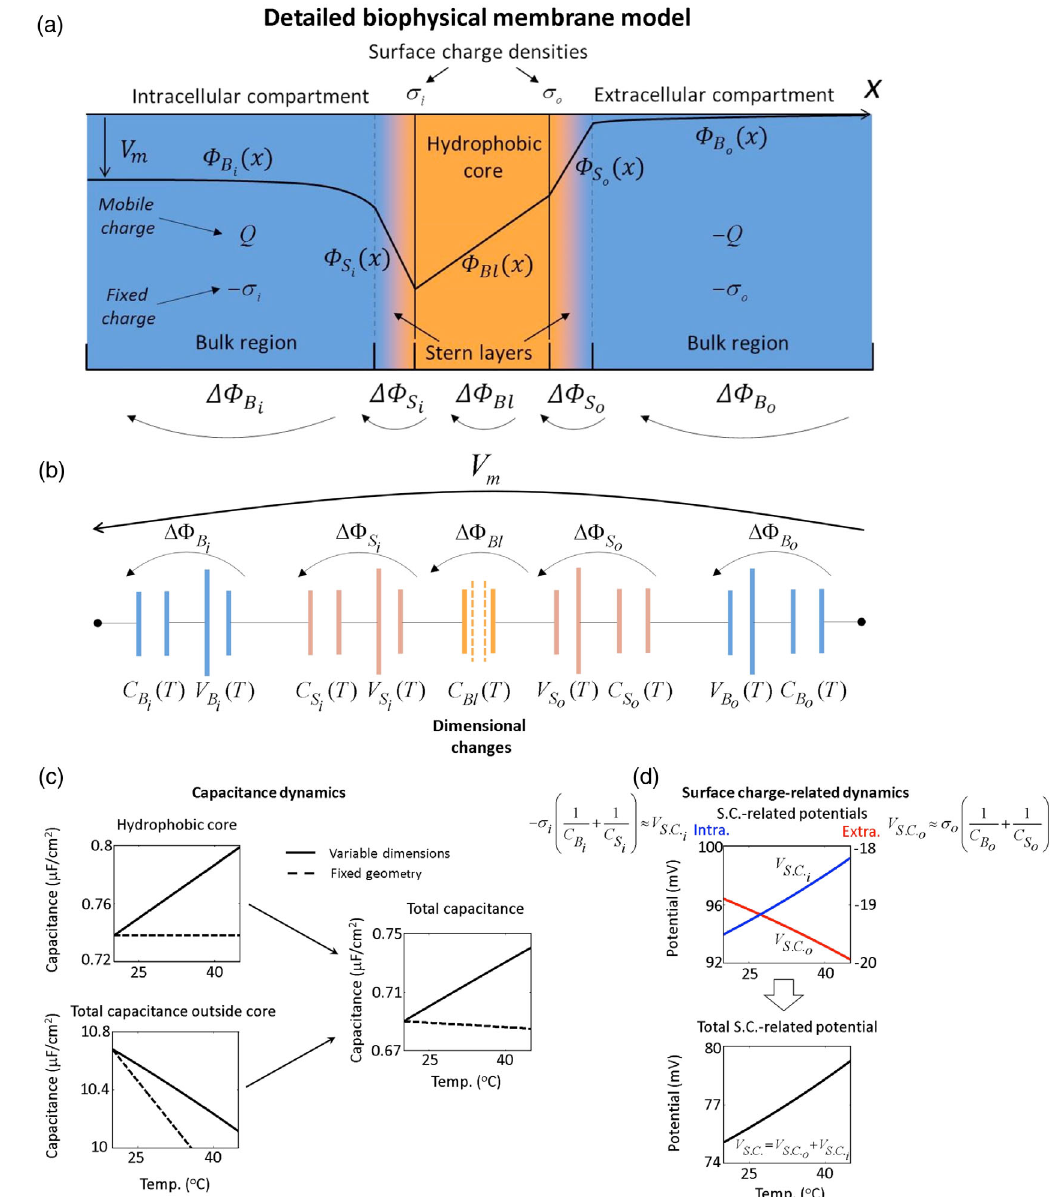
FIG. 2. Detailed (Gouy-Chapman-Stern-based) membrane biophysical model. (a) Membrane subregions: hydrophobic core, containing the phospholipid molecules ’ tails. The outer parts of this region contain intracellular ( σ i ) and extracellular σ o Unhandled Math Content: Z) surface charges. Intracellular and extracellular bulk regions containing mobile charges ( Q and − Q ) and the surface charges ’ fixed counterions ( − σ i and − σ o ). Two Stern layers composed of the phospholipid polar heads and the closest ions to the membrane. ΔΦ j is the P ΔΦ potential drop on each subregion (total, V m ¼ j ). (b) Membrane series circuit where capacitors and sources approximate each subregion ( ΔΦ j ¼ Q=C j þ V j ). V j ≈ − σ i = C j for j ¼ B i or S i and V j ≈ σ o = C j for j ¼ B o or S o is the potential resulting from respective surface charges and both C j and V j are temperature dependent. Overall, Q ¼ C m ð V m − V , where V is the total surface charge- S : C : Þ S : C : related potential. (c) Predicted thermal changes in partial and total membrane capacitance under alternative models: fixed geometry model predicts a net reduction while the varying-dimension model correctly predicts an increase [see also Fig. 1(a)]. (d) Predicted thermal response of intracellular, extracellular (upper panel), and total (bottom panel) surface charge-related relations are determined through the assumption of zero The relationships between the mobile, fixed charges, and density of free charges [16,38,39] (see Sec. IV). the potentials that fall on each membrane region are Interestingly, approximately linear relations between the determined by electrostatic Boltzmann equations in the mobile charge and the potentials are found in all five bulk, while in the hydrophobic core and Stern layers these